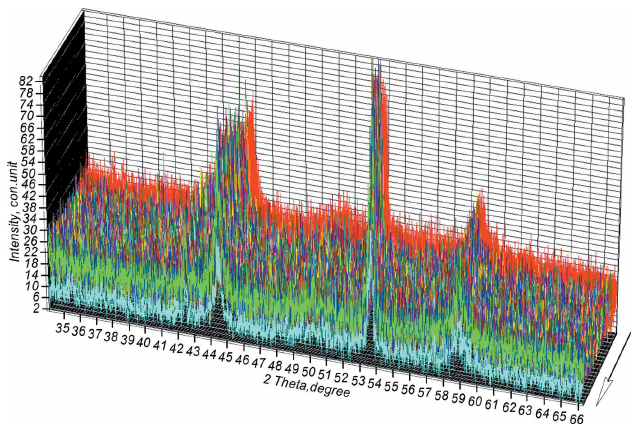
Figure 20 The section of switching off the system (the arrow indicates the direction of the reaction).